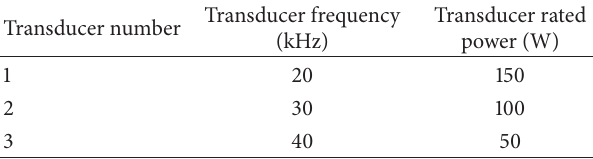
Figure 4: NC-M ultrasound transducer. Table 1: Parameters of ultrasonic transducers.